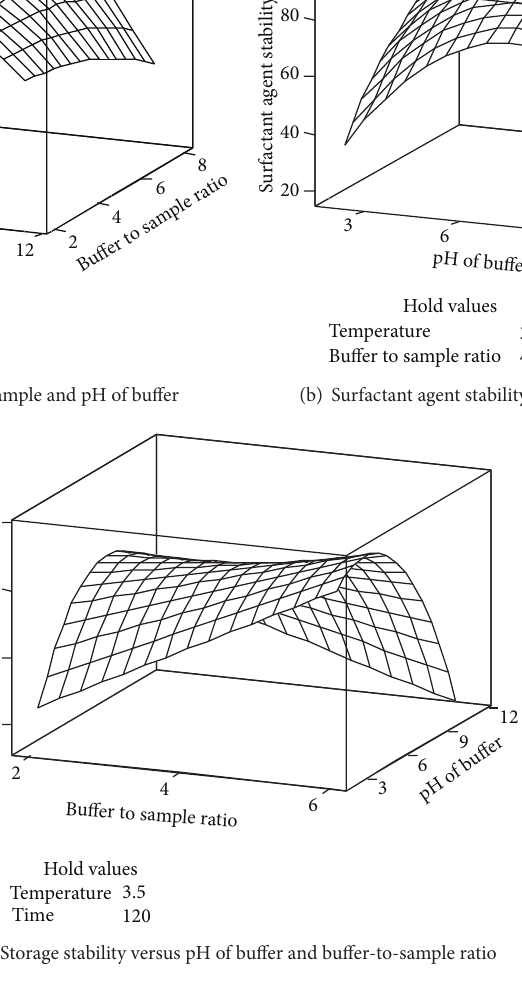
Figure 3: Three-dimensional surface plots for showing the significant interaction effect of independent extraction variables on surfactant agent stability (a-b) and storage stability (c) of amylase were